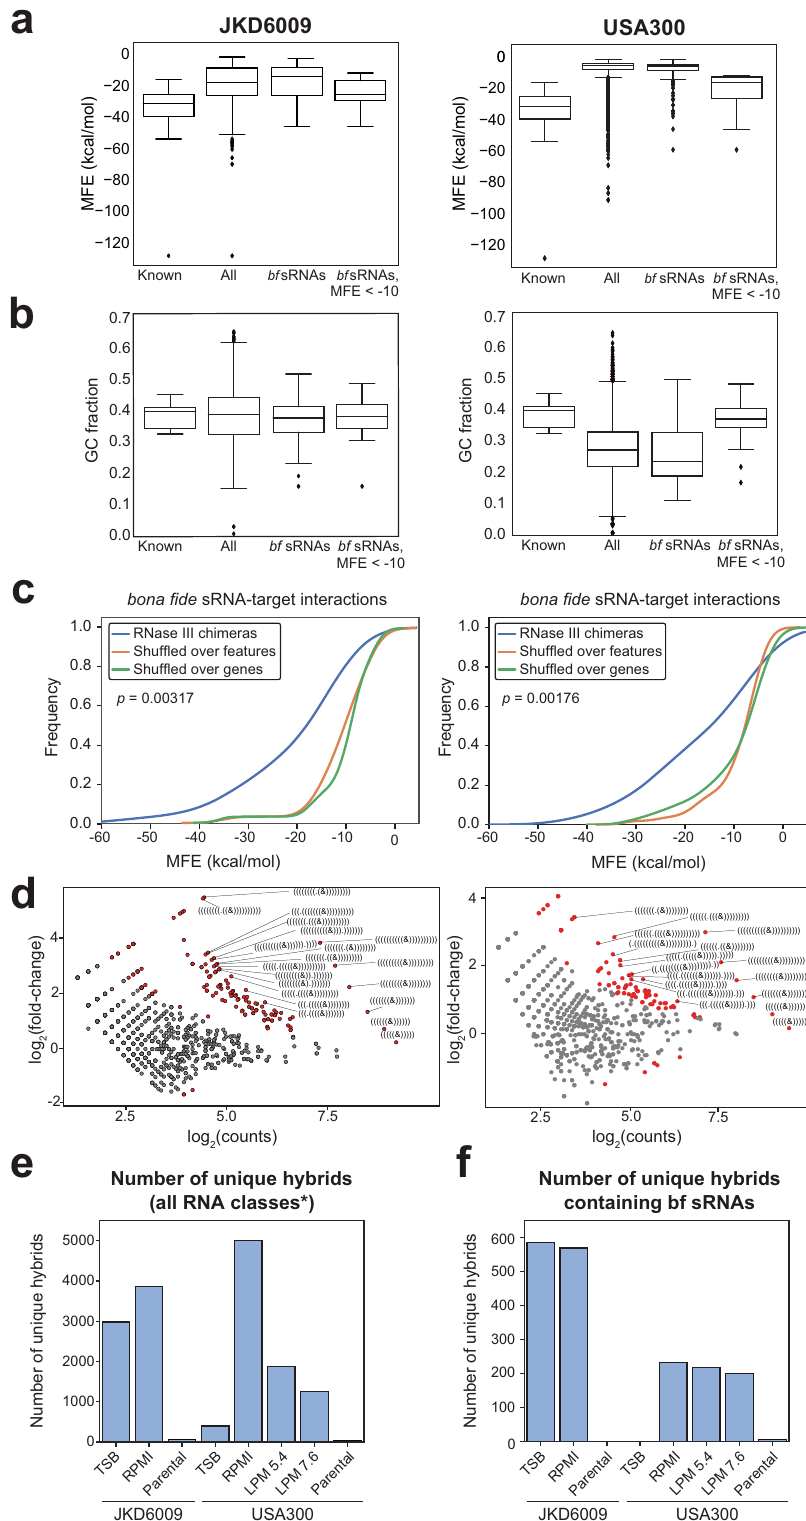
between RsaA-RNAIII in JKD6009 in TSB and RPMI (Supple-